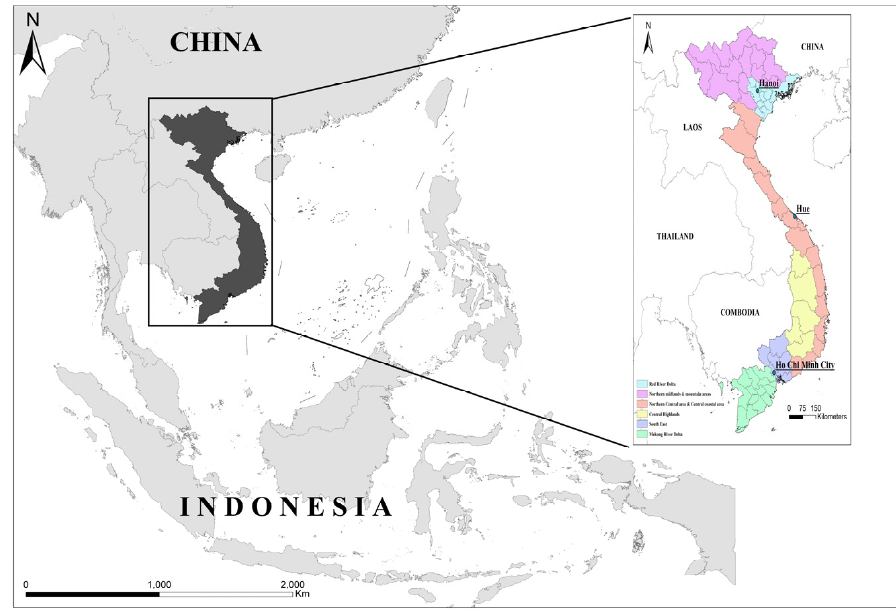
Figure 1. The location of